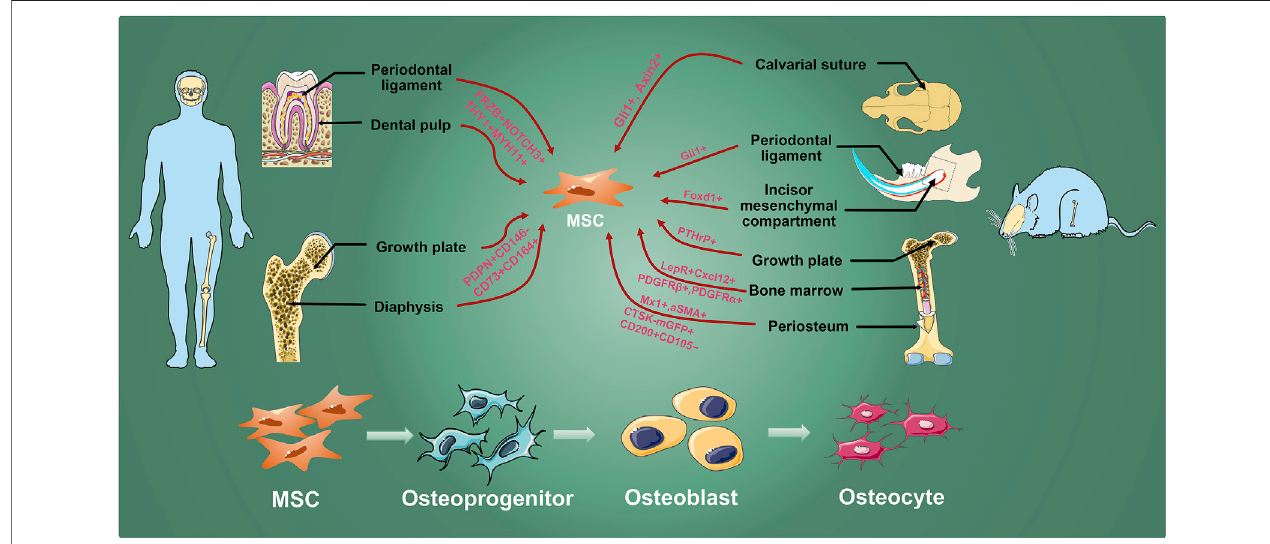
FIGURE 1 | MSC inhabit in various hard tissues. Osteogenic MSCs which are labeled by researchers with different genes exist in human molars and long bones, and mouse calvarial sutures, incisors, molars, and long bones. They are fi nally differentiated into osteocyte through osteoprogenitors and osteoblasts to involve in maintaining bone homeostasis, growth, development, and injury